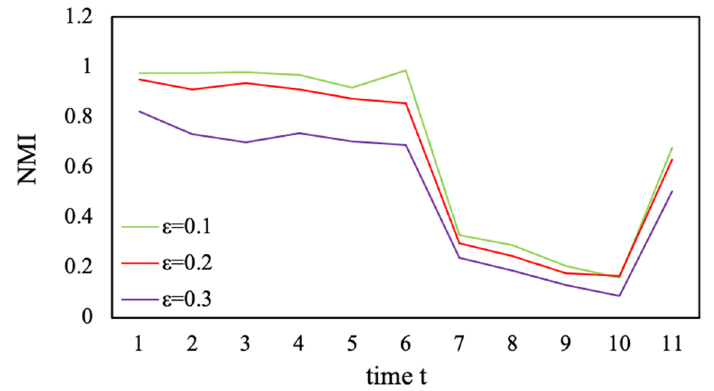
Figure 9. Influence of different (cid:2013) values on NMI value of our